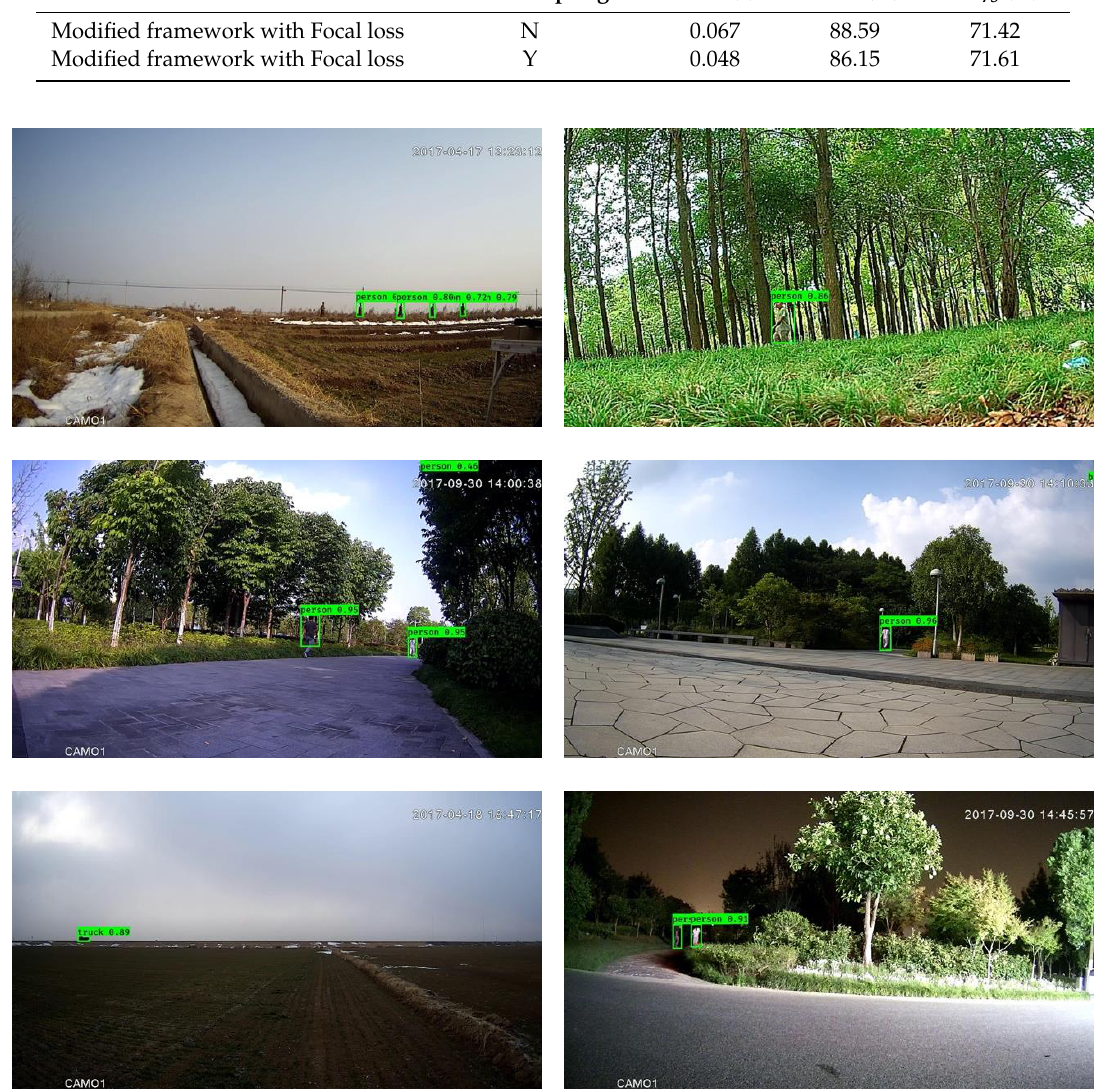
Figure 5. Outcomes of the framework with focal loss and downsampling. Table 5. Results of the modified framework with focal loss with and without downsampling.